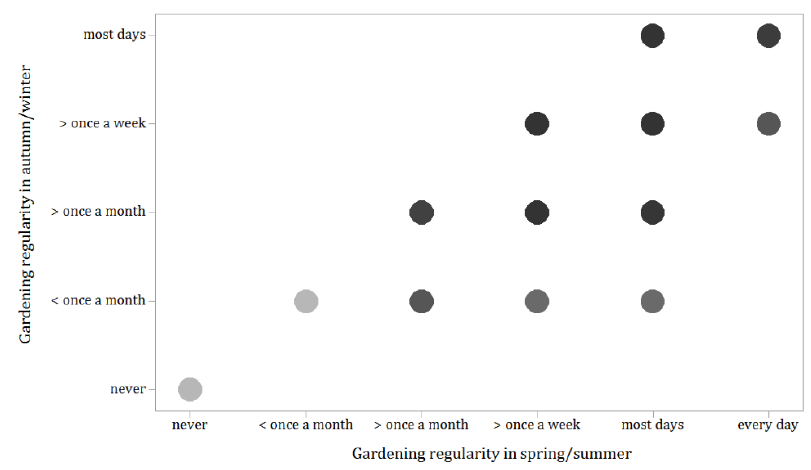
Figure 5. Scatter plot showing the relationship between gardening regularity in spring/summer and autumn/winter. Darker points indicate higher frequency of responses.